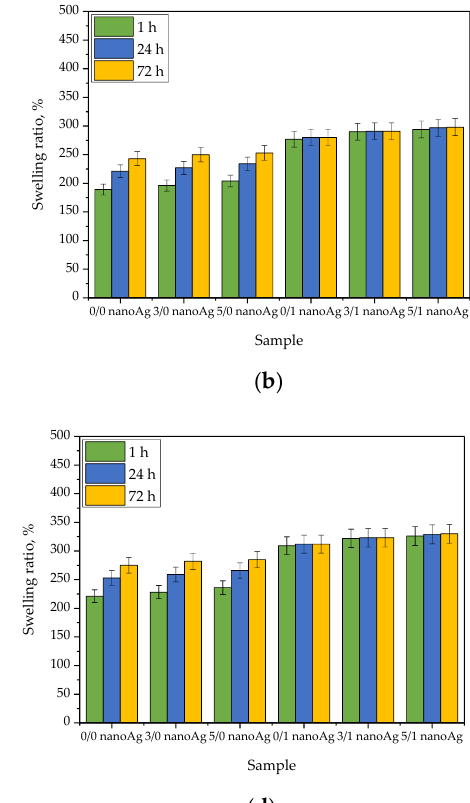
Figure 2. UV–Vis spectrum of the particle suspension obtained as a result of the chemical reduction of silver ions.